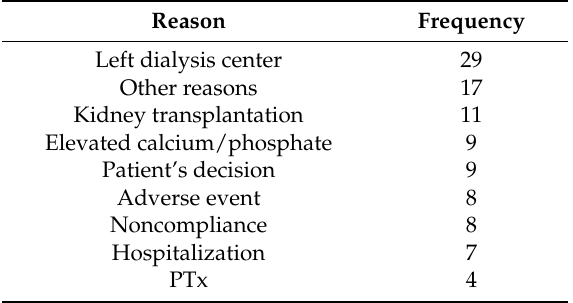
Table 16. Reason for early termination of documentation (all patients).